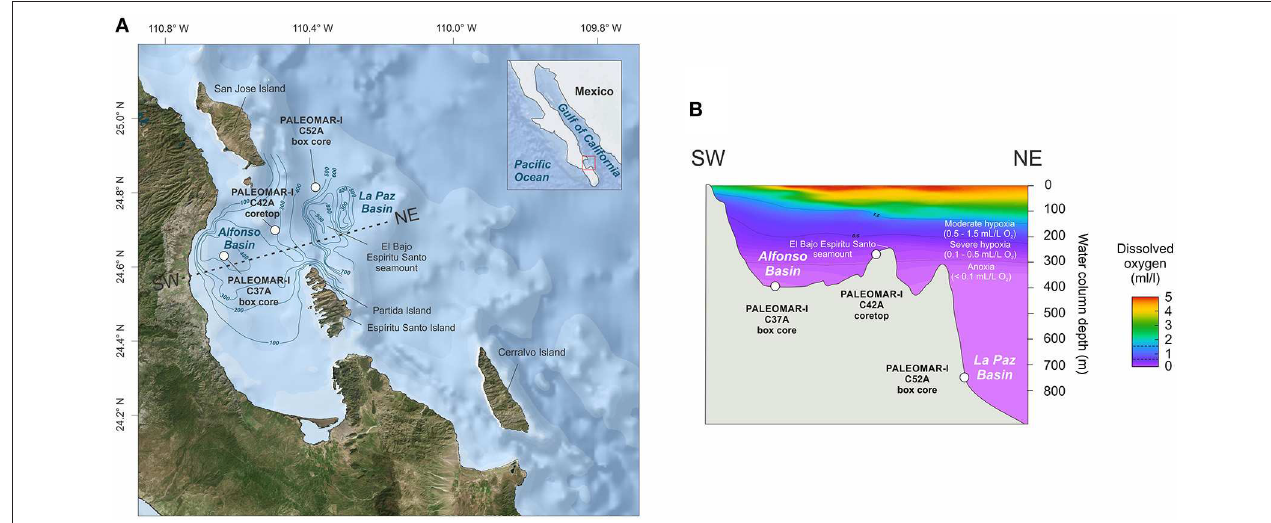
FIGURE 1 | (A) Location of the studied marine setting in the eastern margin of the Gulf of California including the anoxic Alfonso and La Paz basins. The line between SW and NE represents a cross section shown in (B) . (B) Cross section from the Baja California peninsula (SW) to the Gulf of California (NE) representing the basin morphology and dissolved oxygen (mL/L) concentration spanning Alfonso and La Paz basins.